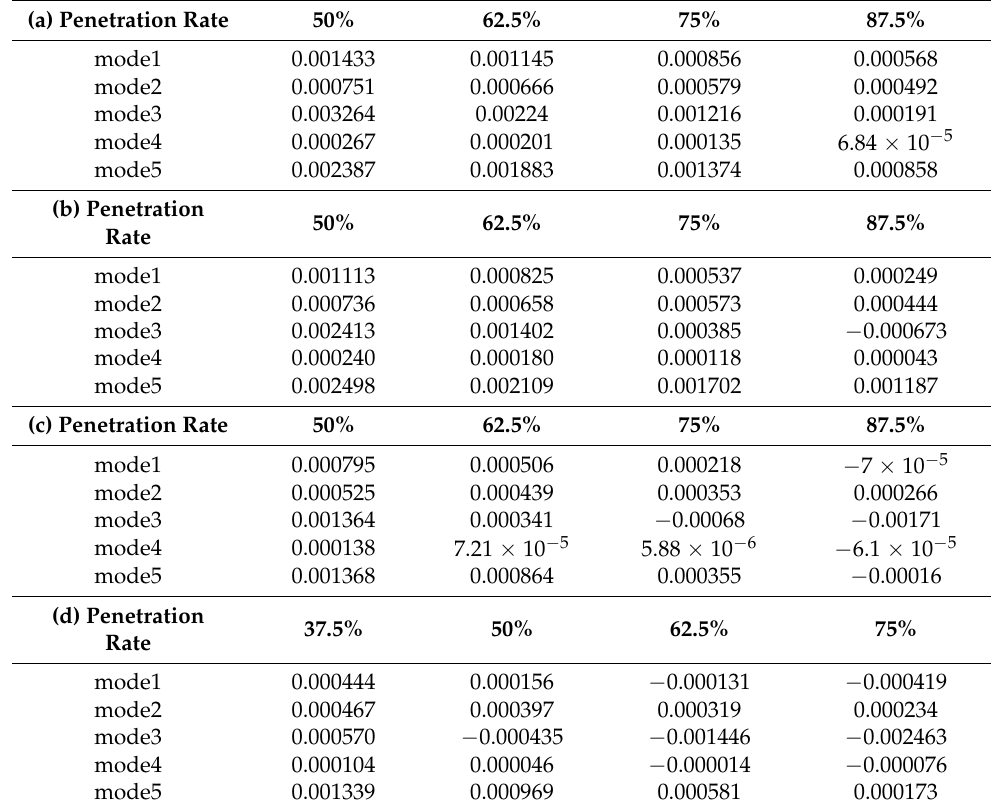
Table 7. ( a ) Torsional mode damping ratios for case 1. ( b ) Torsional mode damping ratios for case